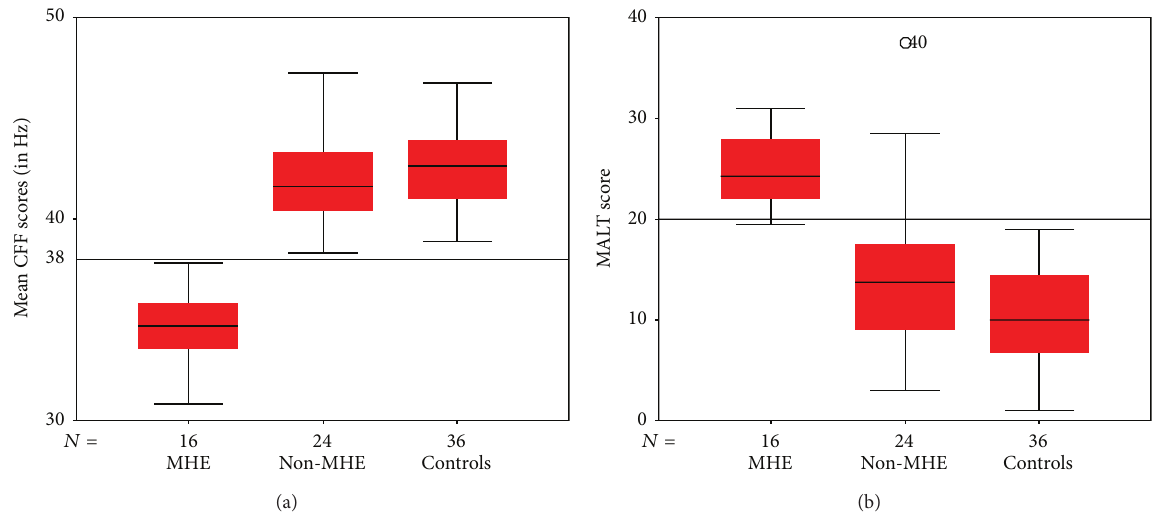
Figure 3: Intergroup comparison for CFF reading and MALT scores. The panel (a) compares the CFF readings between the controls, the non-MHE cirrhotics, and MHE (+) cirrhotics. The panel (b) compares the MALT scores between the same groups.